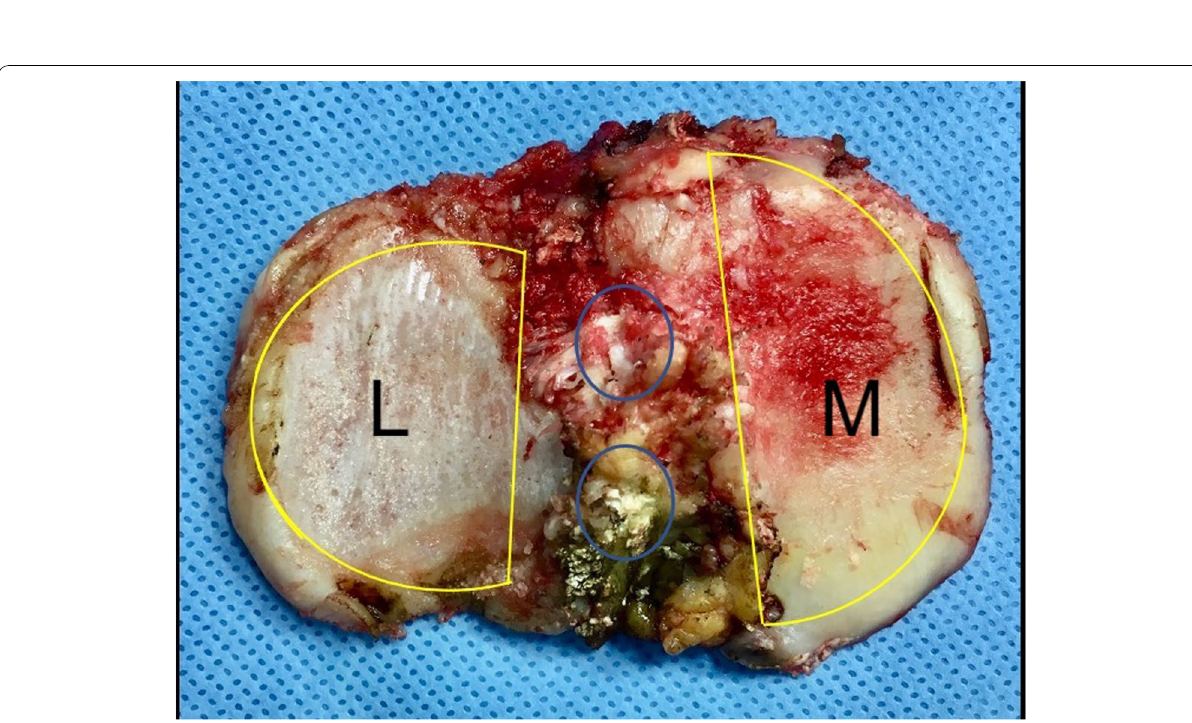
Fig. 5 The two tibial hemi-plateaus have different shapes. The lateral one (L) is more round, the medial one (M) has a drop-like